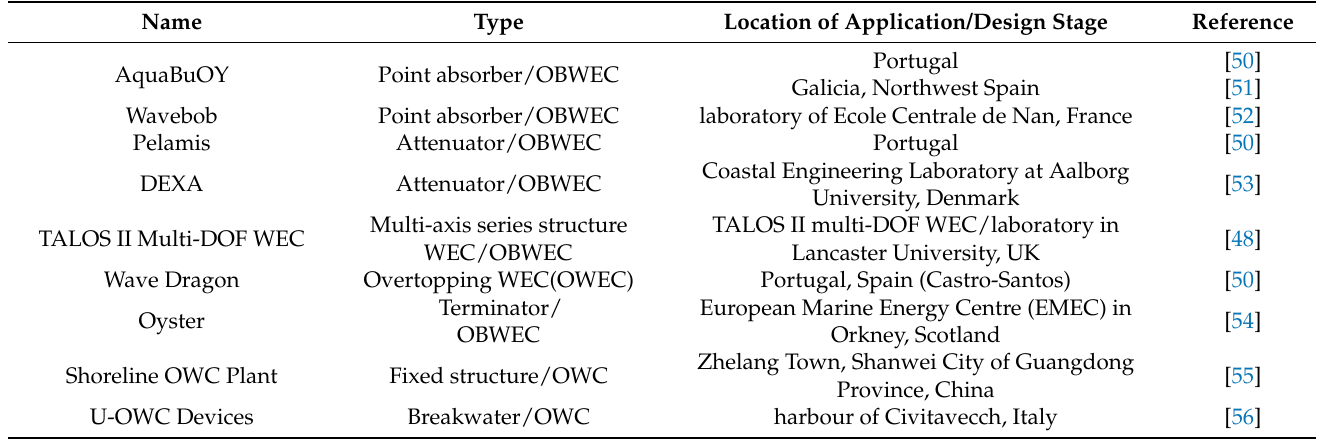
Table 1. Summary of several kinds of